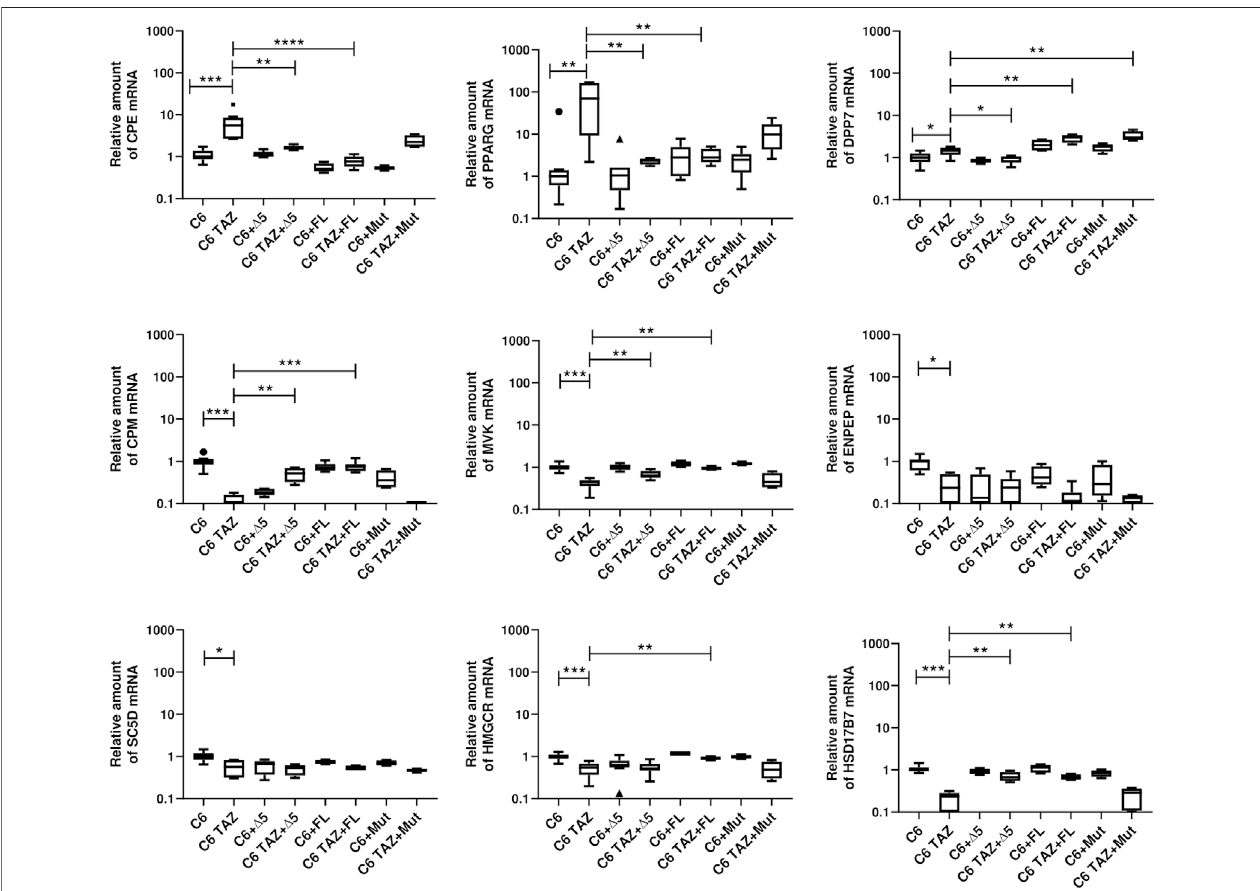
FIGURE 8 | Relative mRNA amount of indicated genes in C6 and C6 TAZ (w/o Δ 5, FL, Mut) is determined by RT-qPCR and normalized to RPLP13a. Data is represented as boxplot with median, quartile and interquartile range.